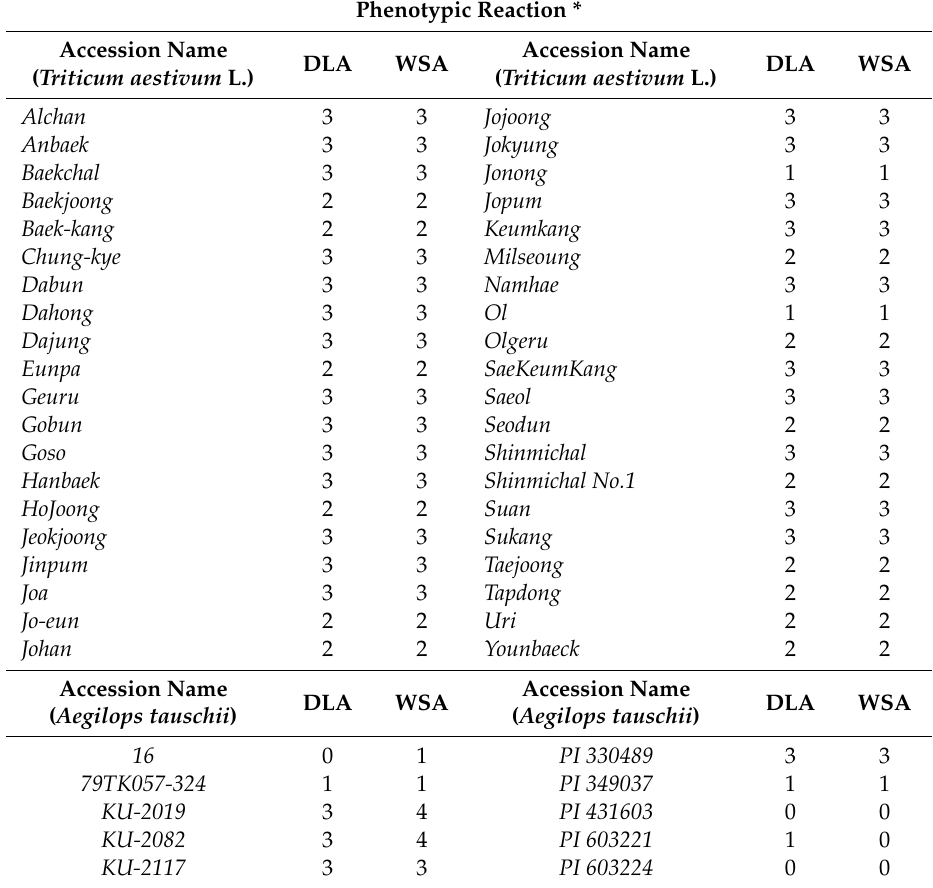
Table 2. Correlation of the phenotypes of various wheat cultivars inoculated with leaf rust between the DLA and the